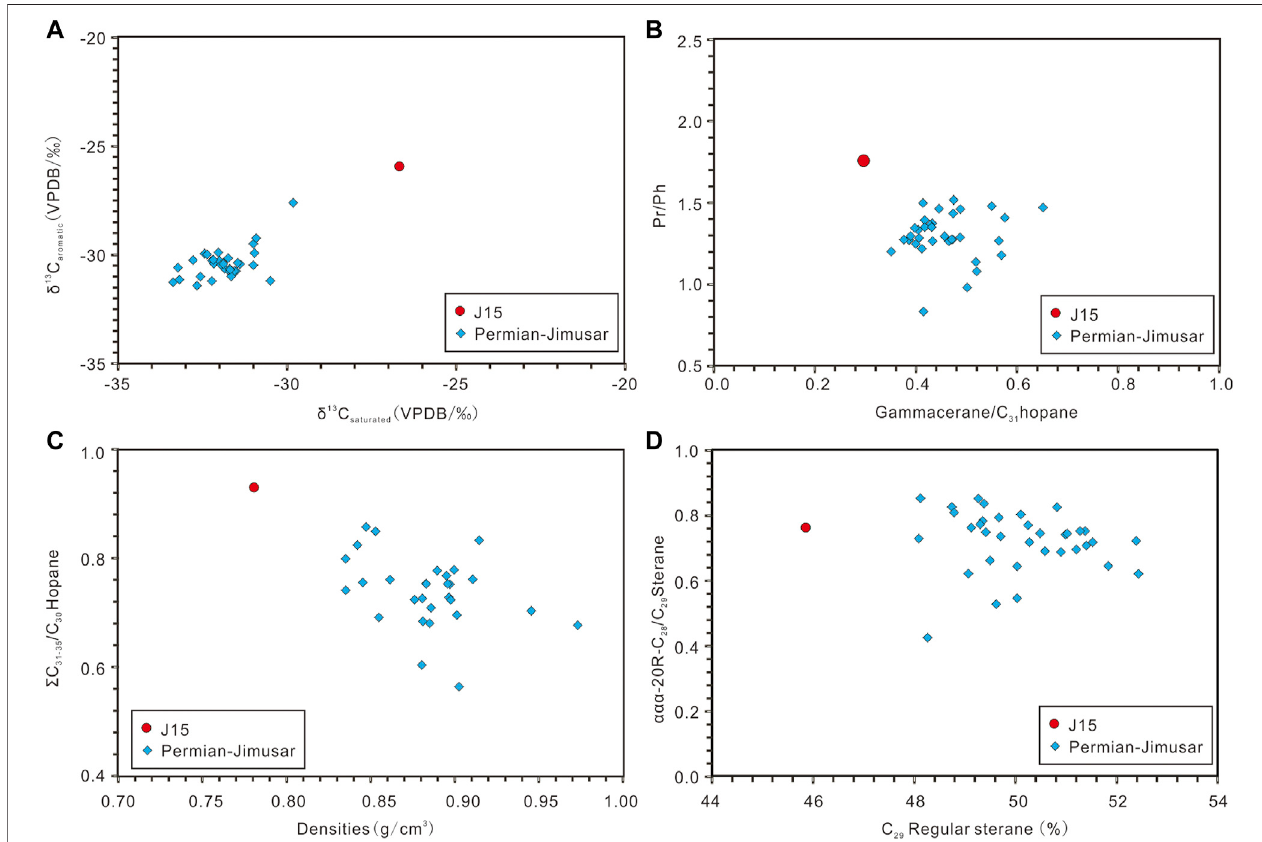
FIGURE 10 | The geochemical characteristics of biomarker fi ngerprints for oils with different types in the Jimsar Sag. (A) : The δ 13 C aromatic vs δ 13 C saturated plot; (B) : ThePr/Phvsgammaceraneindexplot; (C) :ThePr/Phvsgammaceraneindexplot; (B) :The Ʃ C 31 – 35 /C 30 hopaneratiovsdensityplot; (D) :The ααα -20R-C 28 /C 29 sterane ratio vs C 29 regular steranes rato